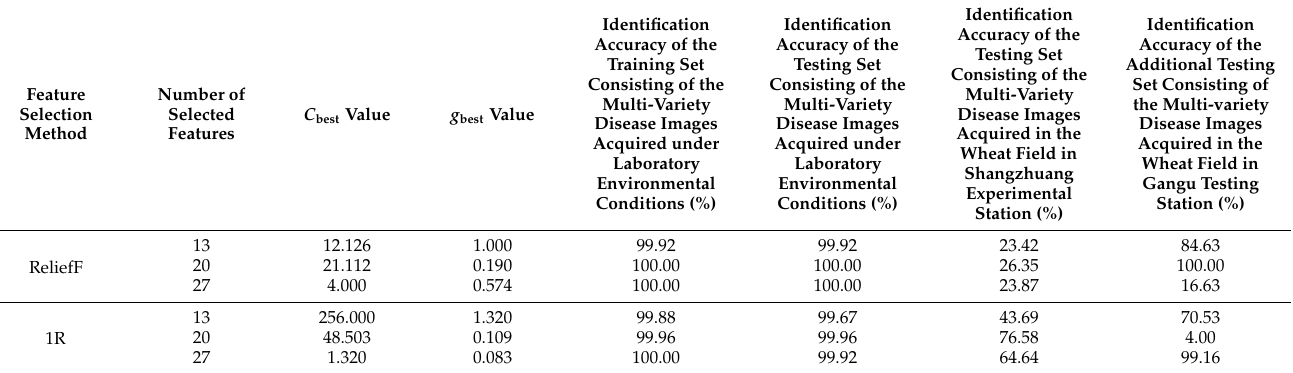
Table 6. Disease identification results of the SVM models built with features selected based on the multi-variety disease image dataset consisting of images acquired under laboratory environmental conditions using feature selection methods including ReliefF and 1R,